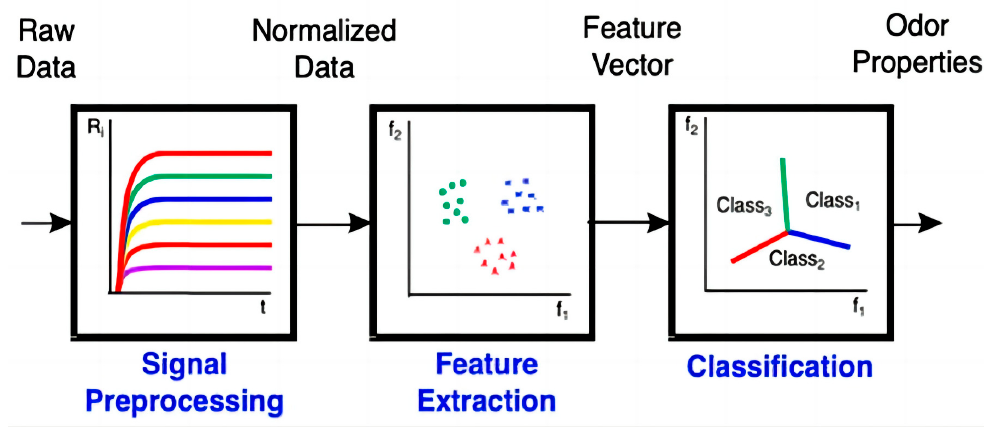
Figure 2. Data analysis in 2021 [29].